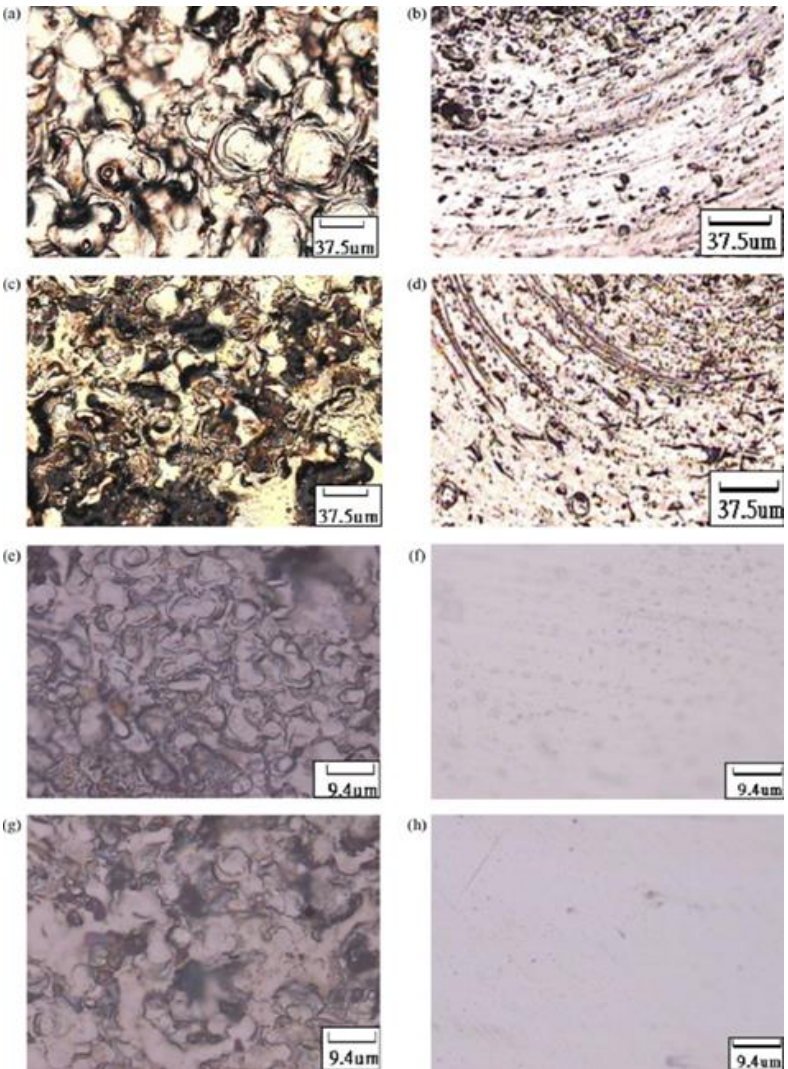
Figure 29. The machined surface for different concentrations of starch and abrasive Al 2 O 3 , under discharge capacitances of 0.068 µF and 0.01 µF: ( a ) 10 wt.% starch without Al 2 O 3 , SR = 1.24 µm C = 0.068 µF; ( b ) 10 wt.% starch - 10 wt.% Al 2 O 3 , SR = 0.26 µm C = 0.068 µF; ( c ) 20 wt.% starch without Al 2 O 3 , SR = 1.12 µm C = 0.068 µF; ( d ) 20 wt.% starch-10 wt.% Al 2 O 3 , SR = 0.14 µm C = 0.068 µF; ( e ) 10 wt.% starch without Al 2 O 3 , SR = 0.52 µm C = 0.01 µF; ( f ) 10 wt.% starch-10 wt.% Al 2 O 3 , SR = 0.06 µm C = 0.01 µF; ( g ) 20 wt.% starch without Al 2 O 3 , SR = 0.46 µm C = 0.01 µF; and ( h ) 20 wt.% starch – 10 wt.% Al 2 O 3 , SR = 0.08 µm C = 0.01 µF [88].